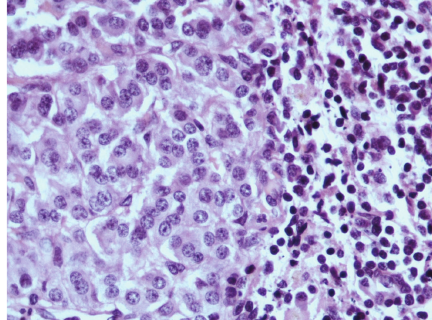
Figure 3: Infiltration of the lymph node by a metastatic neo- plasm consisting of ovoid cells, with “salt and pepper” nuclei (haematoxylin-eosin stain × 400).